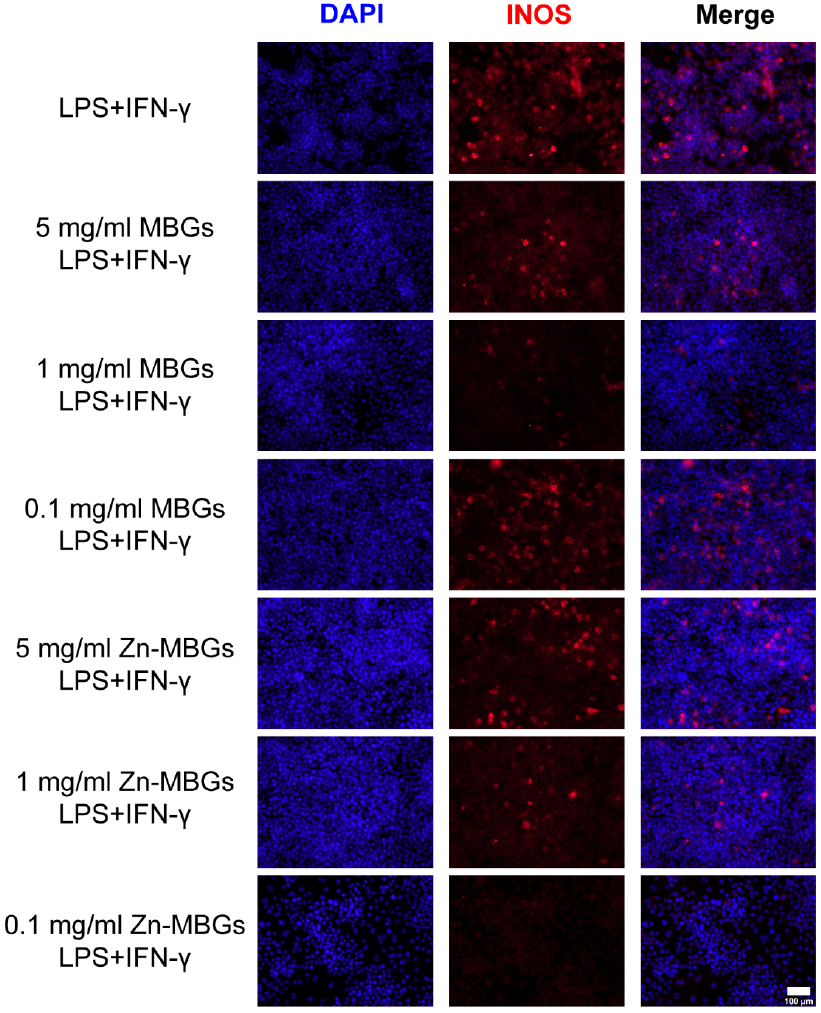
Figure 11. iNOS fluorescence staining of RAW264.7 cells in the presence of LPS (10 ng/mL) and IFN- γ (10 ng/mL) after culture with extracts of MBGs and Zn-MBGs for 24 h. Red and blue staining represent INOS and DAPI,